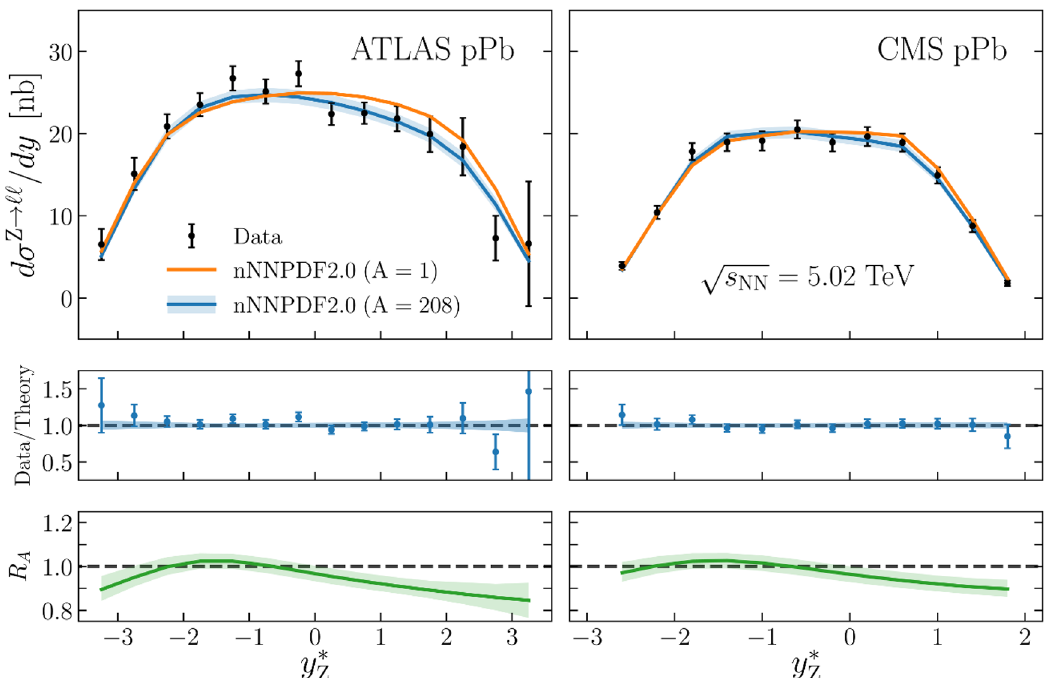
Figure 6 . Comparison between the ATLAS (left) and CMS (right panel) measurements of Z p boson production in proton-lead collisions at s = 5 : 02 TeV with the theoretical predictions using nNNPDF2.0 as input. We show the predictions obtained both for A = 1 and A = 208, in the later case including the 90% con(cid:12)dence level band. From top to bottom, the three panels display the absolute cross-sections, the ratio between data and theory, and the nuclear modi(cid:12)cation R A ( y